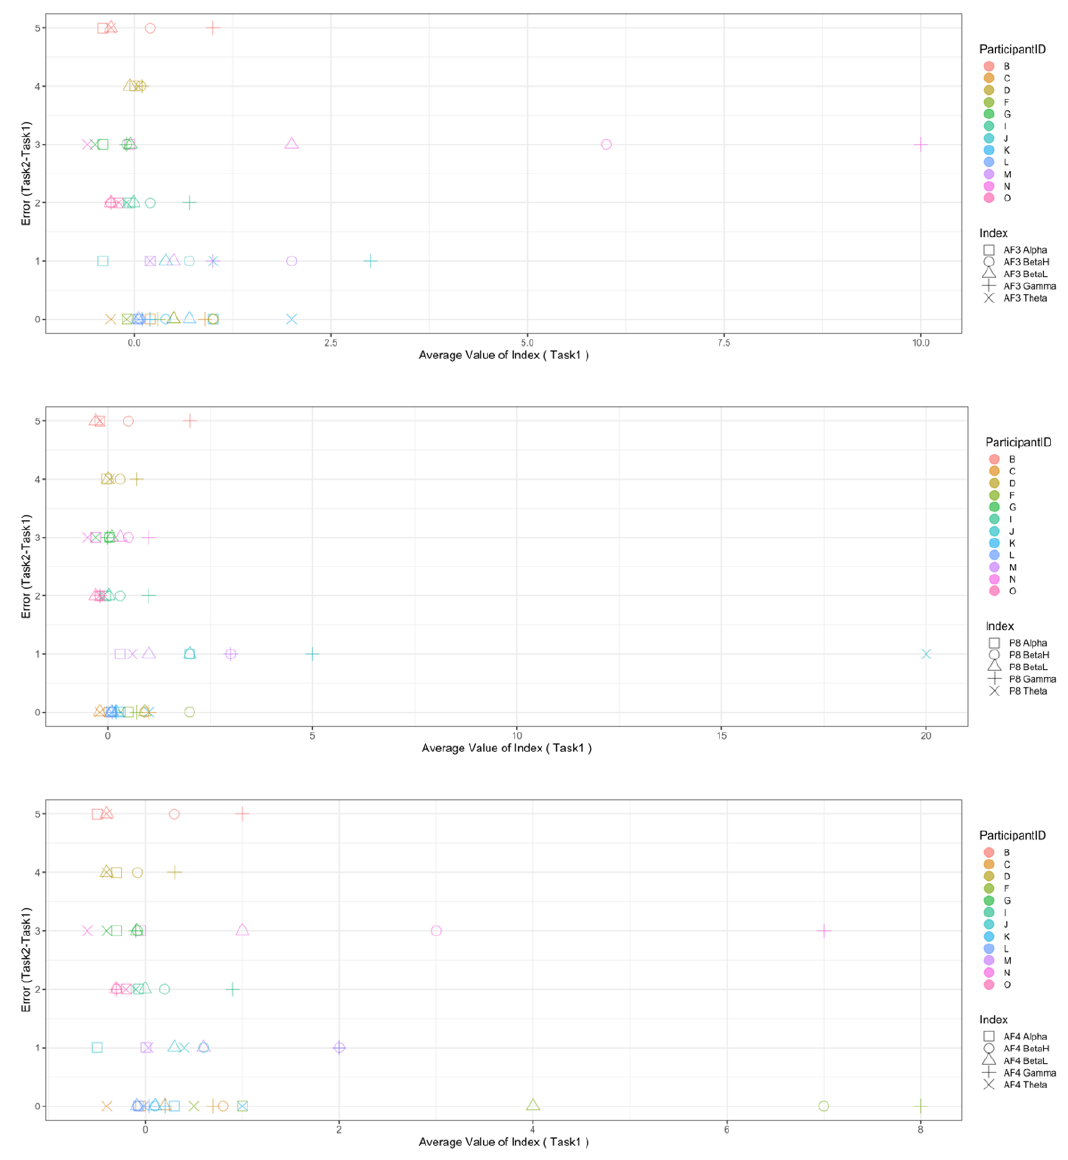
Figure 11. Scatterplot between the number of errors of Task1 vs. the EEG indexes during Task1. (Note that the scatterplots include only EEG channels with significant correlations (AF3, P8, and AF4) as summarized in Table 17).